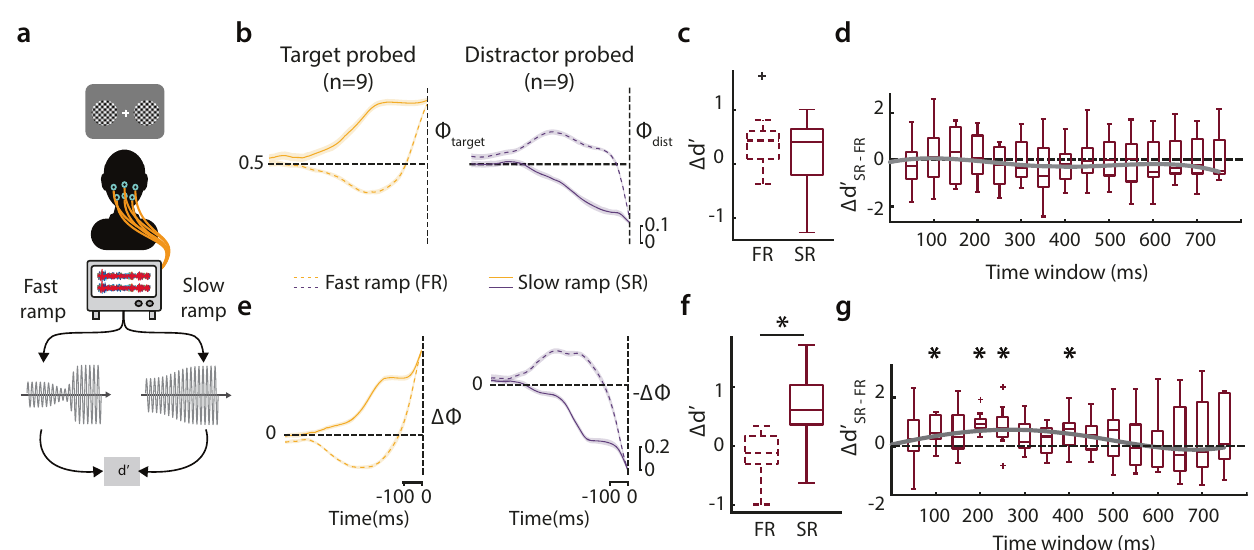
Fig. 5 Slow-ramping dynamics of ΔΦ yield stronger d ′ enhancements. a Schematic depicting the analysis protocol for investigating behavioral differences between trials with fast or slow-ramping Φ (or ΔΦ ) dynamics. b Mean Φ traces for the target-side (left, yellow) and distractor-side (right, purple) probed trials on the target and distractor side, respectively, leading up to grating presentation (dashed vertical line). Dashed and solid lines: fast-ramping trials ( n = 9) and slow-ramping trials ( n = 9), respectively. Trials pooled across subjects for Paradigm B. Shaded regions: s.e.m. c Difference in perceptual accuracy ( Δ d ′ ) between target-side and distractor-side probed trials, computed separately for fast-ramping (FR) and slow-ramping (SR) subsets. Dashed and solid outline boxes: fast-ramping and slow-ramping trials, respectively. Central mark: median, edges: 25th and 75th percentiles, the whiskers: most extreme points, + : outliers. d The difference in Δ d ′ between slow-ramping and fast-ramping trials ( Δ d ′ SR – FR ) at different time-windows used for computing the rate of variation of Φ before threshold crossing. Central mark: median, edges: 25th and 75th percentiles, the whiskers: most extreme points, + : outliers. Solid gray line: Quartic polynomial fi t. e Same as in b , but showing mean ΔΦ ( Φ target − Φ distractor ) trace for the target-side (left, yellow) and − ΔΦ ( Φ distractor − Φ target ) trace for the distractor-side (right, purple) probed trials. Other conventions are the same as in panel b . f Same as in c , but Δ d ′ for fast- ramping and slow-ramping trials based on ΔΦ dynamics. Other conventions are the same as in panel e . * p < 0.05. g Same as in d , but Δ d ′ SR – FR for fast- ramping and slow-ramping trials based on ΔΦ dynamics. * p <